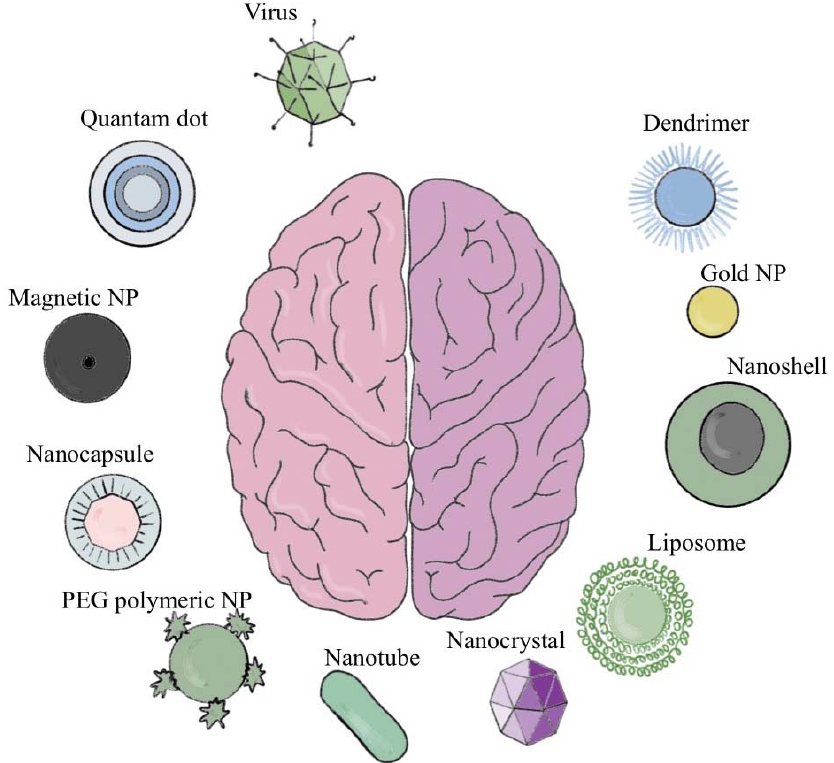
Figure 2. A graphical representative of the current strategies for brain drug delivery [18,19]. Abbreviation: NP ‐ nanoparticles; PEG ‐ polyethylenoglicol.